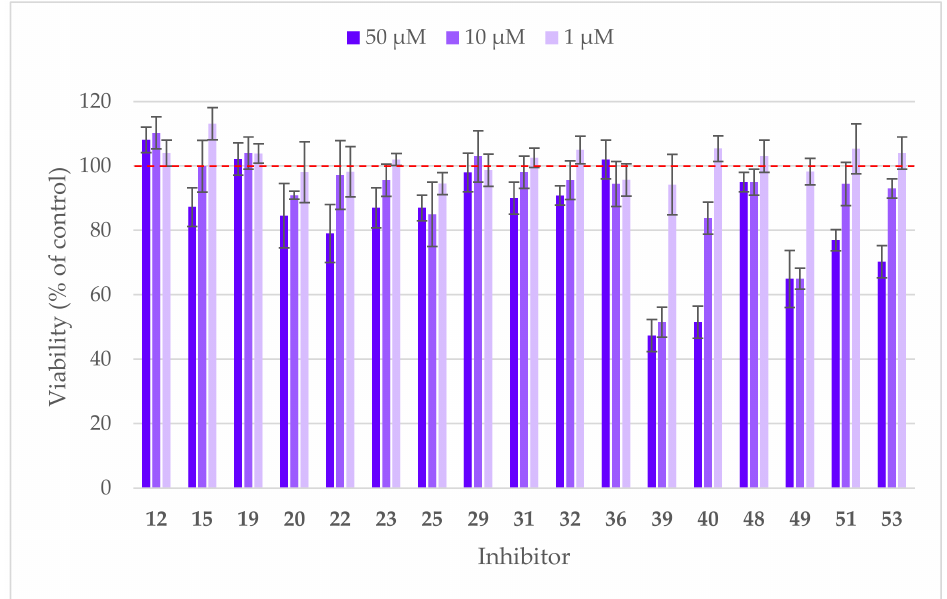
Figure 3. Cytotoxicity of active compounds on Hep G2 cell line was evaluated at three different concentrations. Data are represented as mean values ± standard